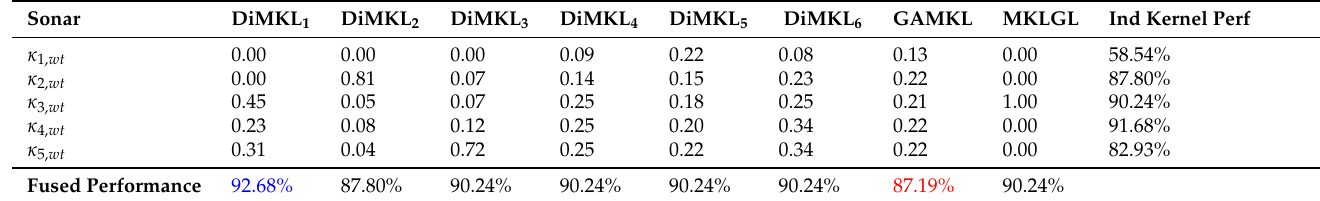
Table 7. Sonar: highest performing method is shown in blue; lowest performing is shown in red.